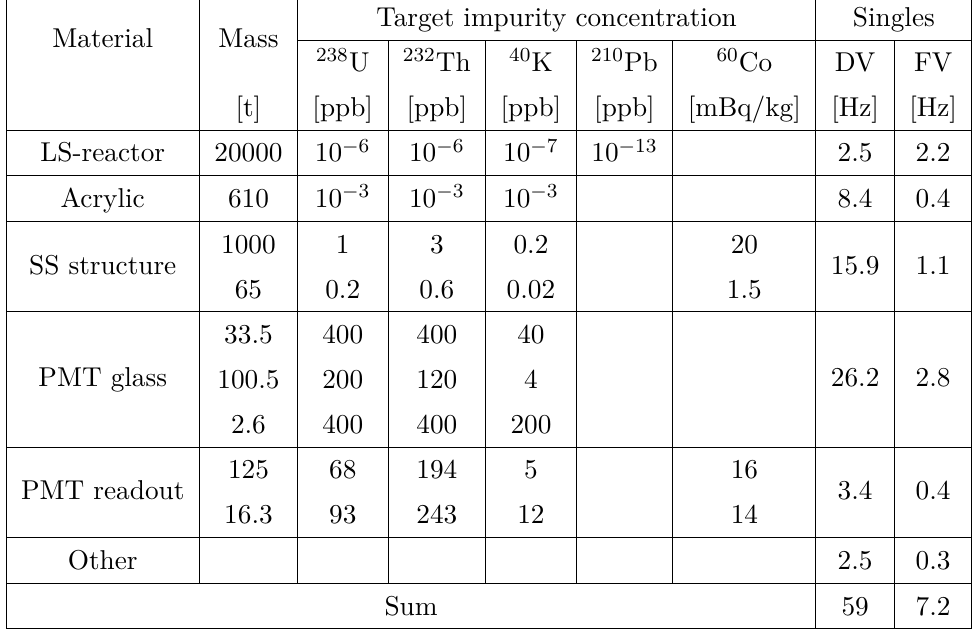
Table 4. Final background budget for the main materials used in the JUNO detector with recon- structed energy E larger than 0.7 MeV. The expected count rates are given both in the full DV rec ( r = 17.7 m) and in the default FV ( r = 17.2 m). The “Other” components include all materials LS LS that have relatively smaller contribution to the background (compare with table 3), such as the calibration parts, the LPMT cover, the rock, and the radon in water. These results include energy resolution, optical propagation, charge reconstruction, and non-uniformity